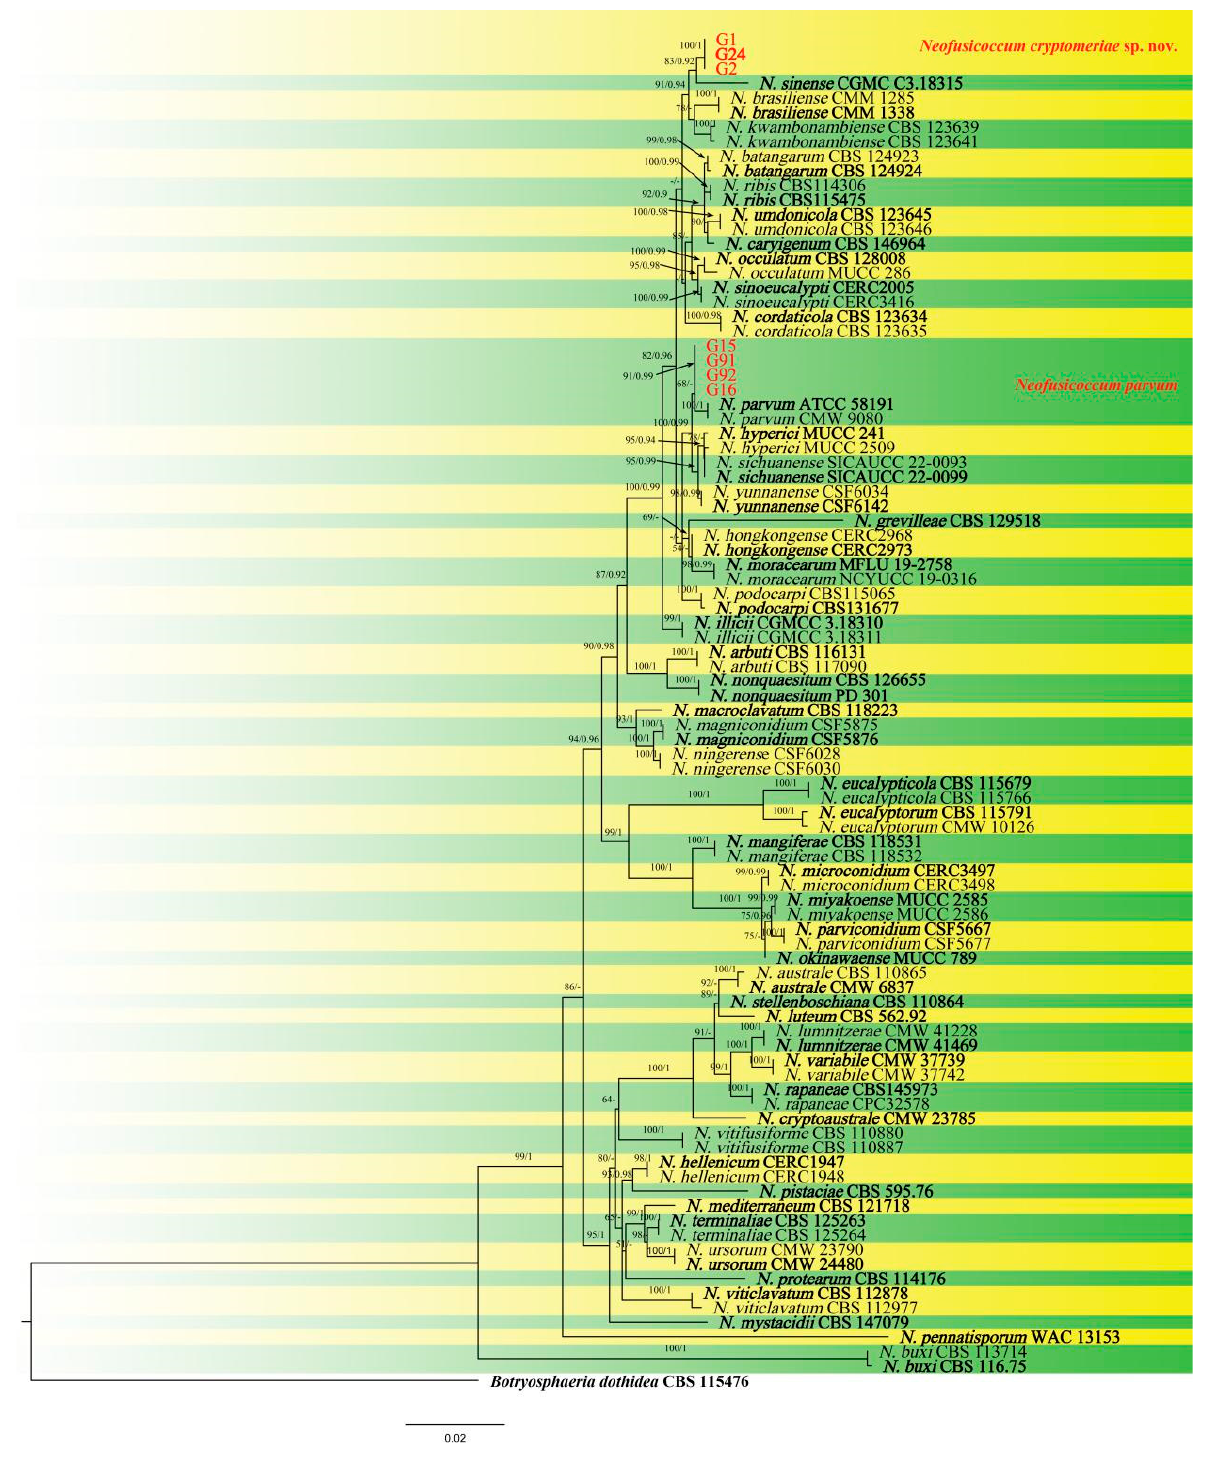
Figure 3. Phylogenetic relationship of Neofusicoccum cryptomeriae and N. parvum with closely related taxa derived from a maximum likelihood (ML) analysis and Bayesian Inference using combined ITS, tef1 , tub2, and rpb2 sequence alignment, with Botryosphaeria dothidea (CBS 115476) as the outgroup. Maximum likelihood bootstrap support values (ML ≥ 50) and Bayesian posterior probability (PP ≥ 0.90) are shown at the nodes (ML/PP). Ex-type strains are marked in bold, the species are delimited with colored blocks, and isolates in this study are marked in red.